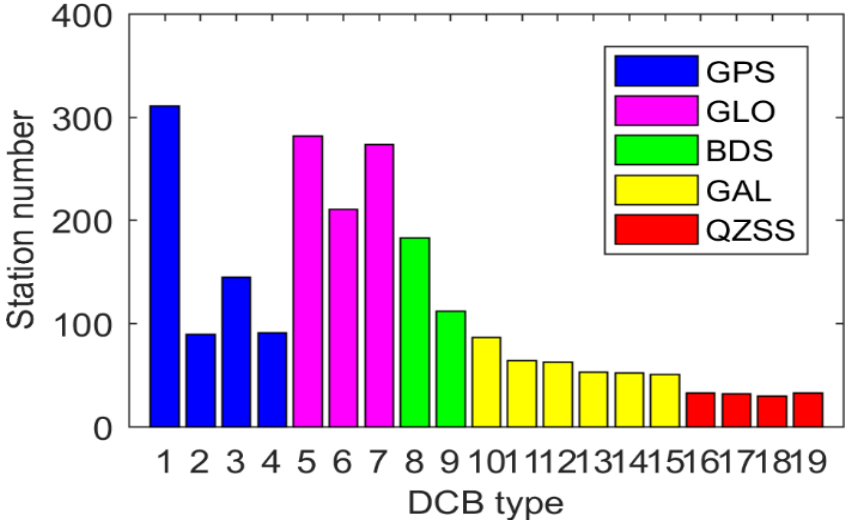
Figure 4. Number of available stations for different DCB type estimation.